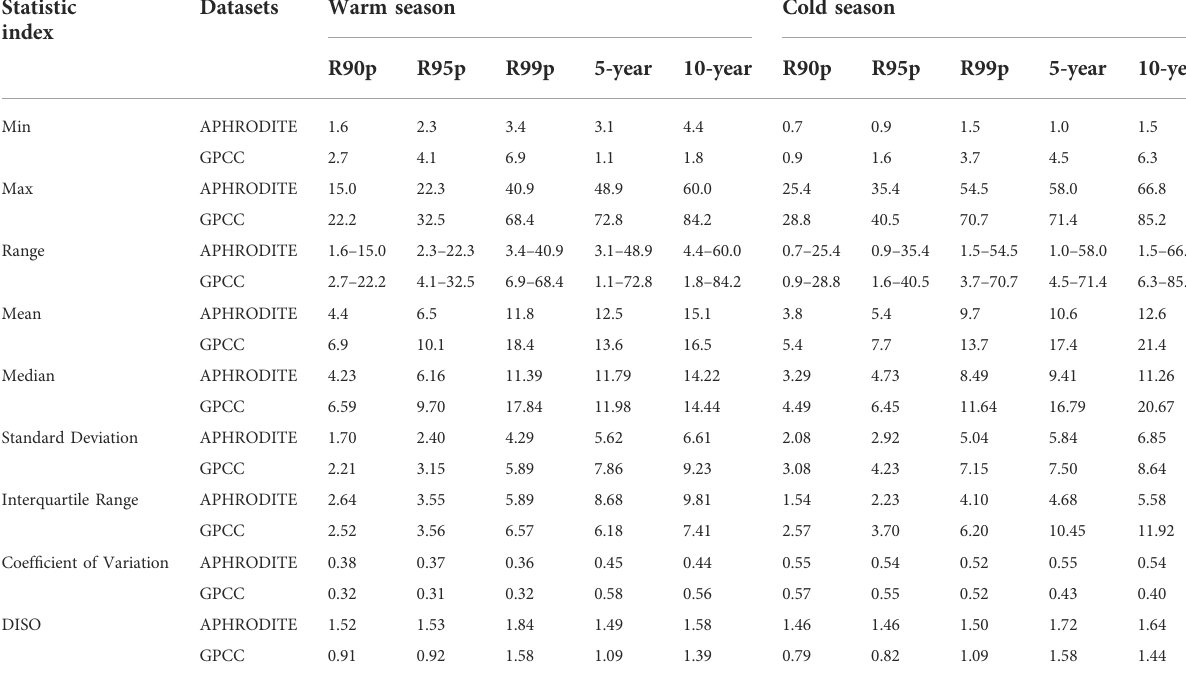
TABLE 3 The statistic of different extreme threshold creteria by APHRODITE and GPCC